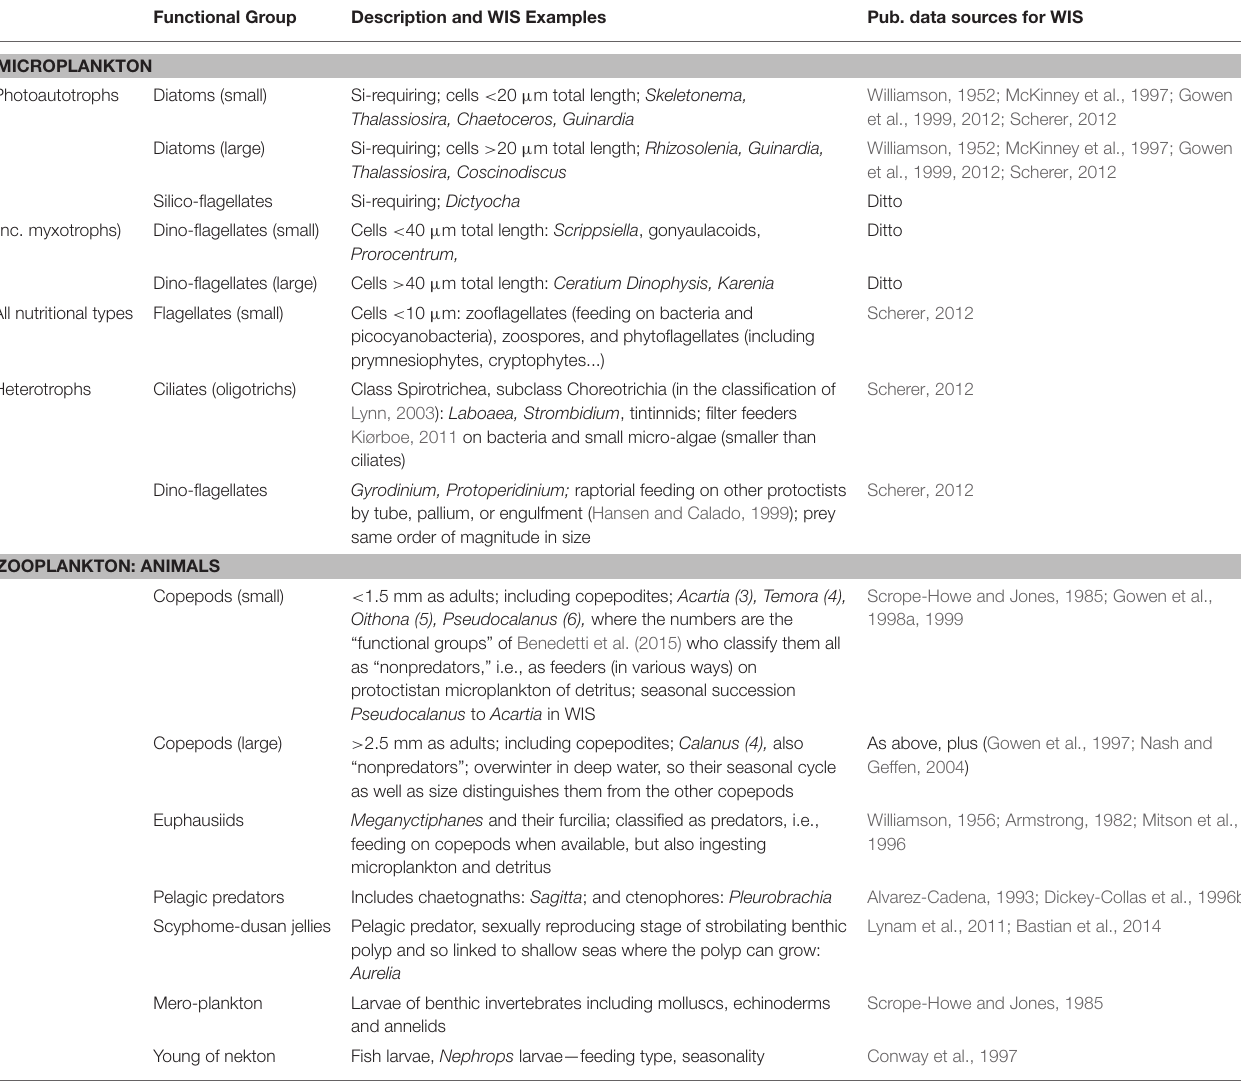
TABLE 4 | Functional groups of plankton defined for the present study of the WIS. Functional